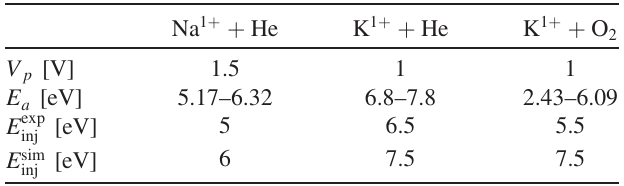
TABLE IX. Comparison of optimum 1 þ injection energies from theoretical calculations, experiments and MCBC simula-